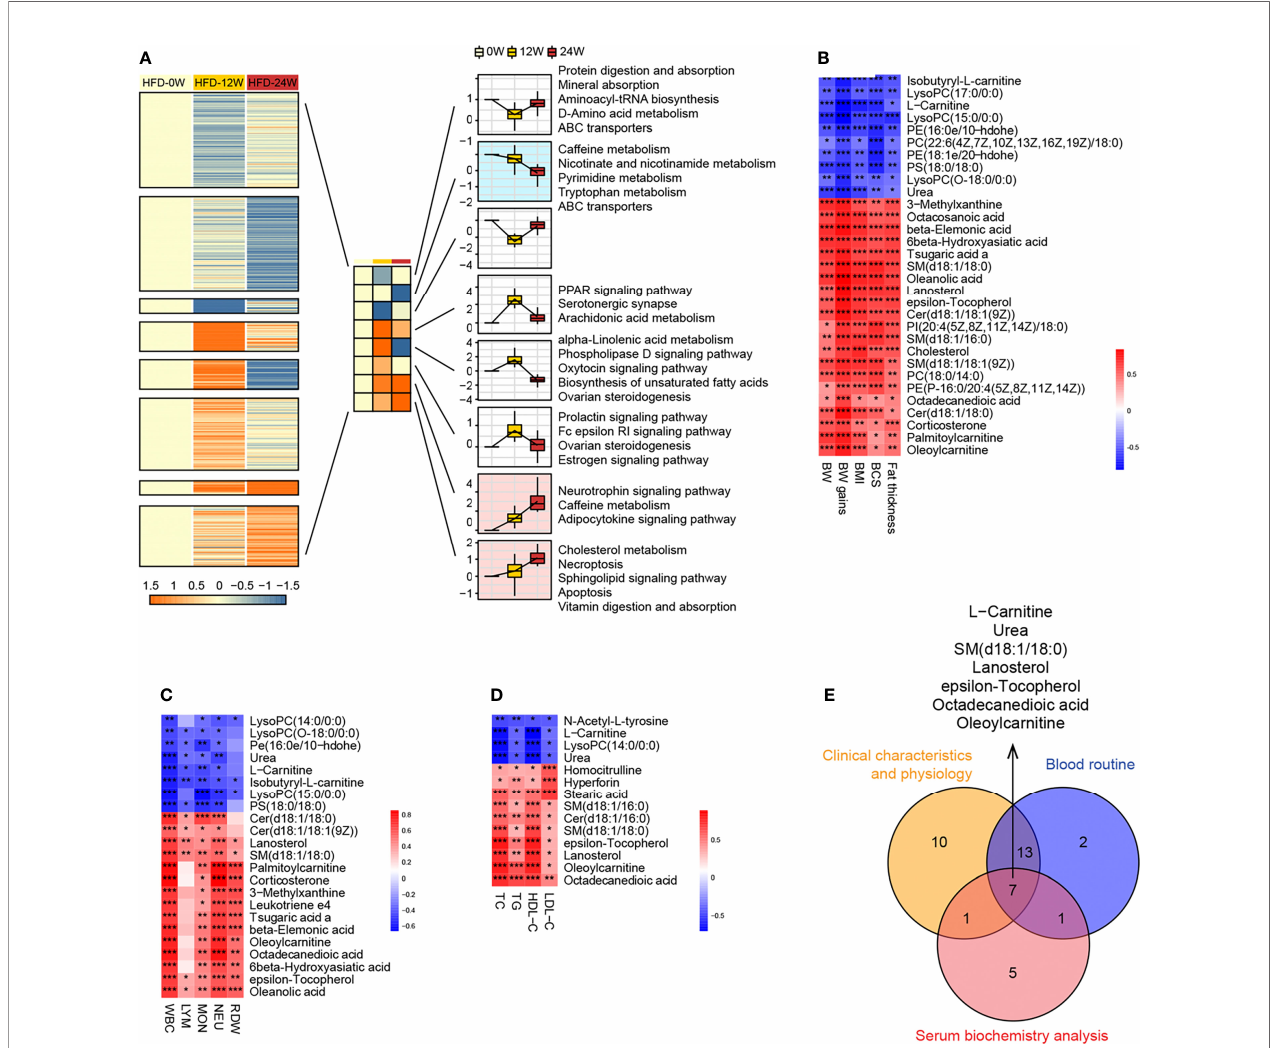
FIGURE 6 | Correlation research between plasma metabolites and animal phenotypes representing obesity and metabolic disorder. (A) Dynamic pattern diagram of KEGG pathway variation during 0, 12 and 24 weeks of HFD feeding. All pathways are divided into eight clusters according to the trend characteristics of K-means at three time points. Clusters with the trend of continuously declining (mint blue) or elevated (light pink) K-means were selected for subsequent analysis. (B – D) Heatmaps indicate the correlation between plasma endogenous metabolites and animal phenotypes related to metabolic disorders, including physical examination (B) , routine blood tests (C) , and serum biochemistry (D) . Signi fi cance levels * P <0.05, ** P <0.01, *** P <0.001. (E) Venn diagram shows 7 endogenous metabolites that are signi fi cantly associated with all three